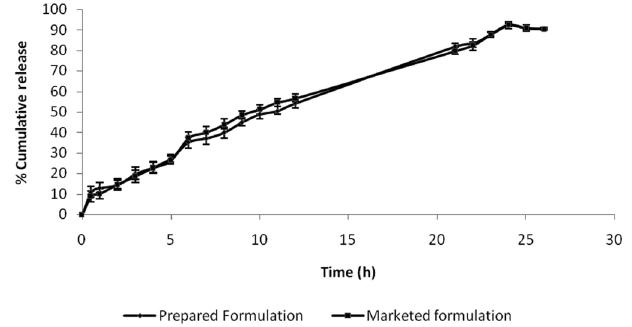
FIGURE 2 - Comparative study of dissolution profile of optimized formulation and marketed Formulation.